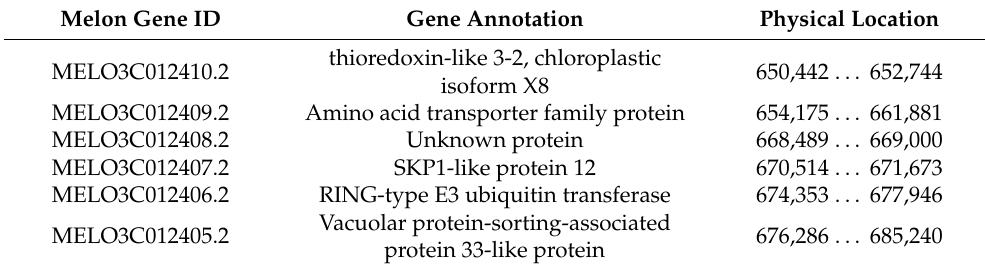
Table 4. Predicted genes between